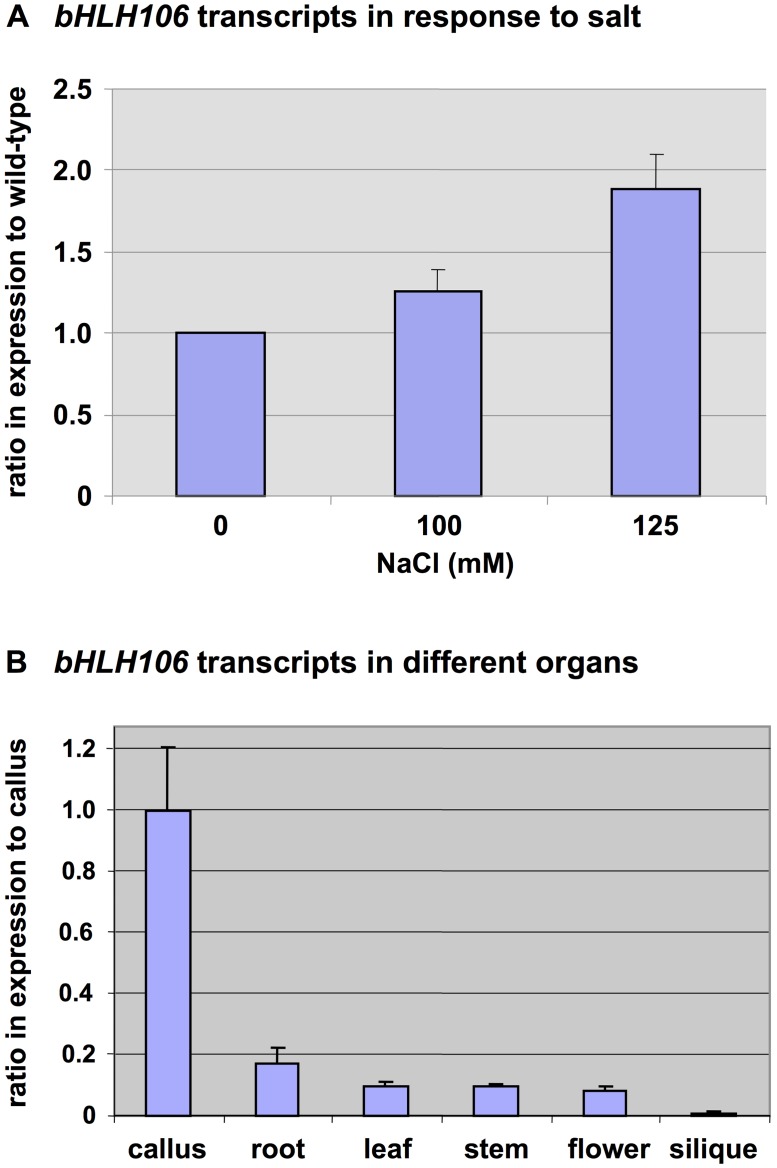
Expression of bHLH106 with regard to salt-response and organ-specificity.(A) bHLH106 transcripts in response to salt. Plants were transferred to salt-containing medium 4 days after germination, and kept vertical for 2 weeks. Total RNA was extracted from whole plants and subjected to real-time RT-PCR with normalization using ACTIN2 (ACT2). Error bars represent ±SEM from three experimental replicates. All the P values are less than 0.05 between 0 mM NaCl and 100 mM or 125 mM NaCl. (B) bHLH106 transcripts in different organs. The wild-type plants were grown under standard conditions. RNA was extracted from mature plants. Expression was determined by real-time RT-PCR and normalized using ACTIN2 (ACT2). Error bars represent ±SEM from three experimental replicates.